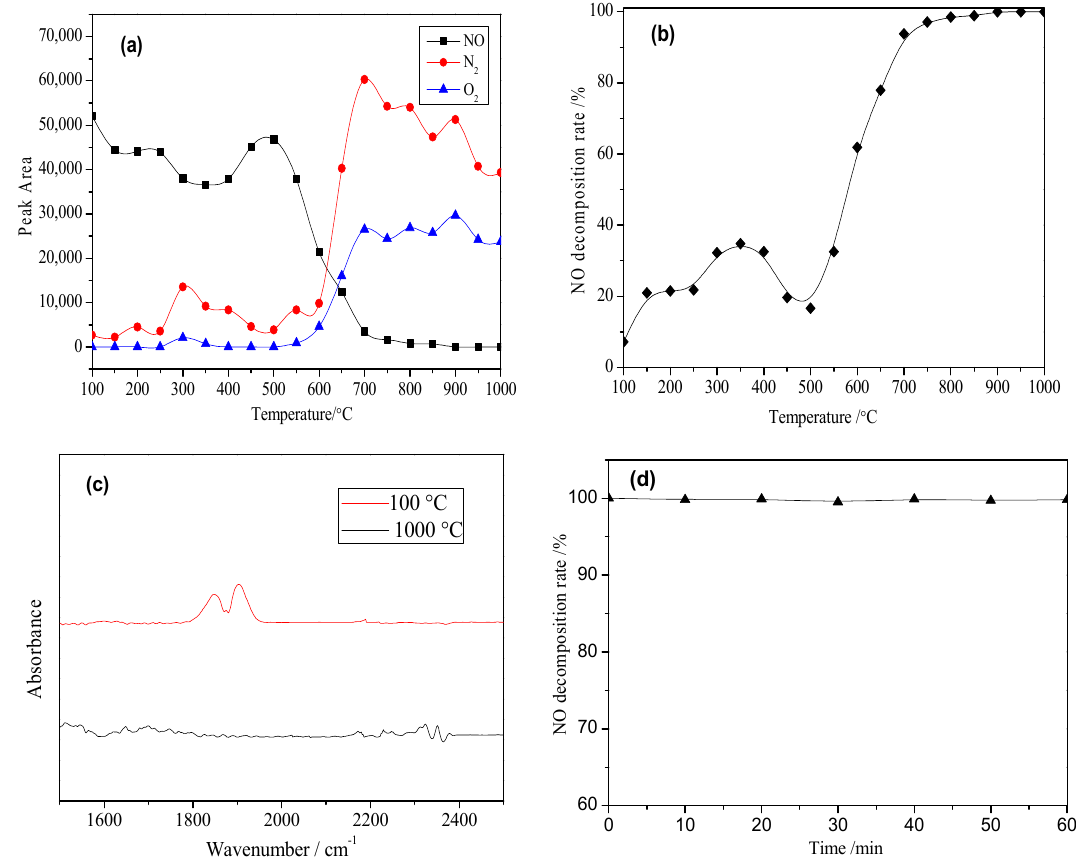
Figure 6. Denitrification results of porous material with CTAB tested by micro gas chromatography (GC) and Fourier Transform Infrared Spectroscopy (FTIR). ( a ) Peak area of different gases after denitrification; ( b ) NO decomposition rate of porous material; ( c ) FTIR spectra of reaction gas after denitrification at different temperatures; ( d ) NO decomposition rate of porous material when the temperature is kept at 1000 °C for 60 min.